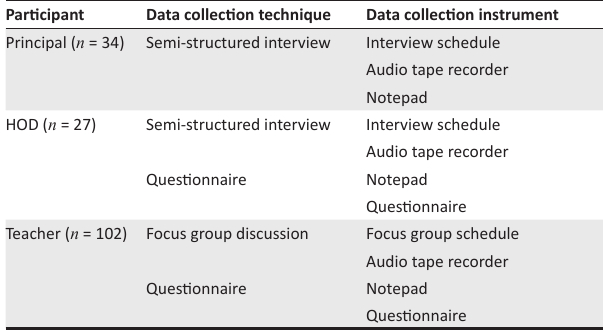
FIGURE 2: Participating primary schools per TABLE 1: Research participants.